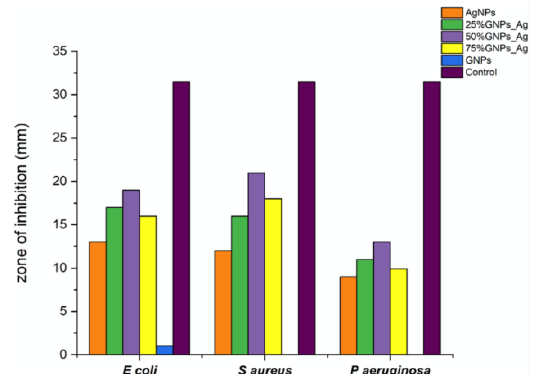
Figure 8. Zone diameters generated by AgNPs, (Ag) 1−x (GNPs) x and GNPs against Escherichia coli, Styphylococcus aureus and Pseudomonas aeruginosa . Table 1. ZOI generated by AgNPs, (Ag) 1 − x (GNPs) x and GNPs against bacterial strains.